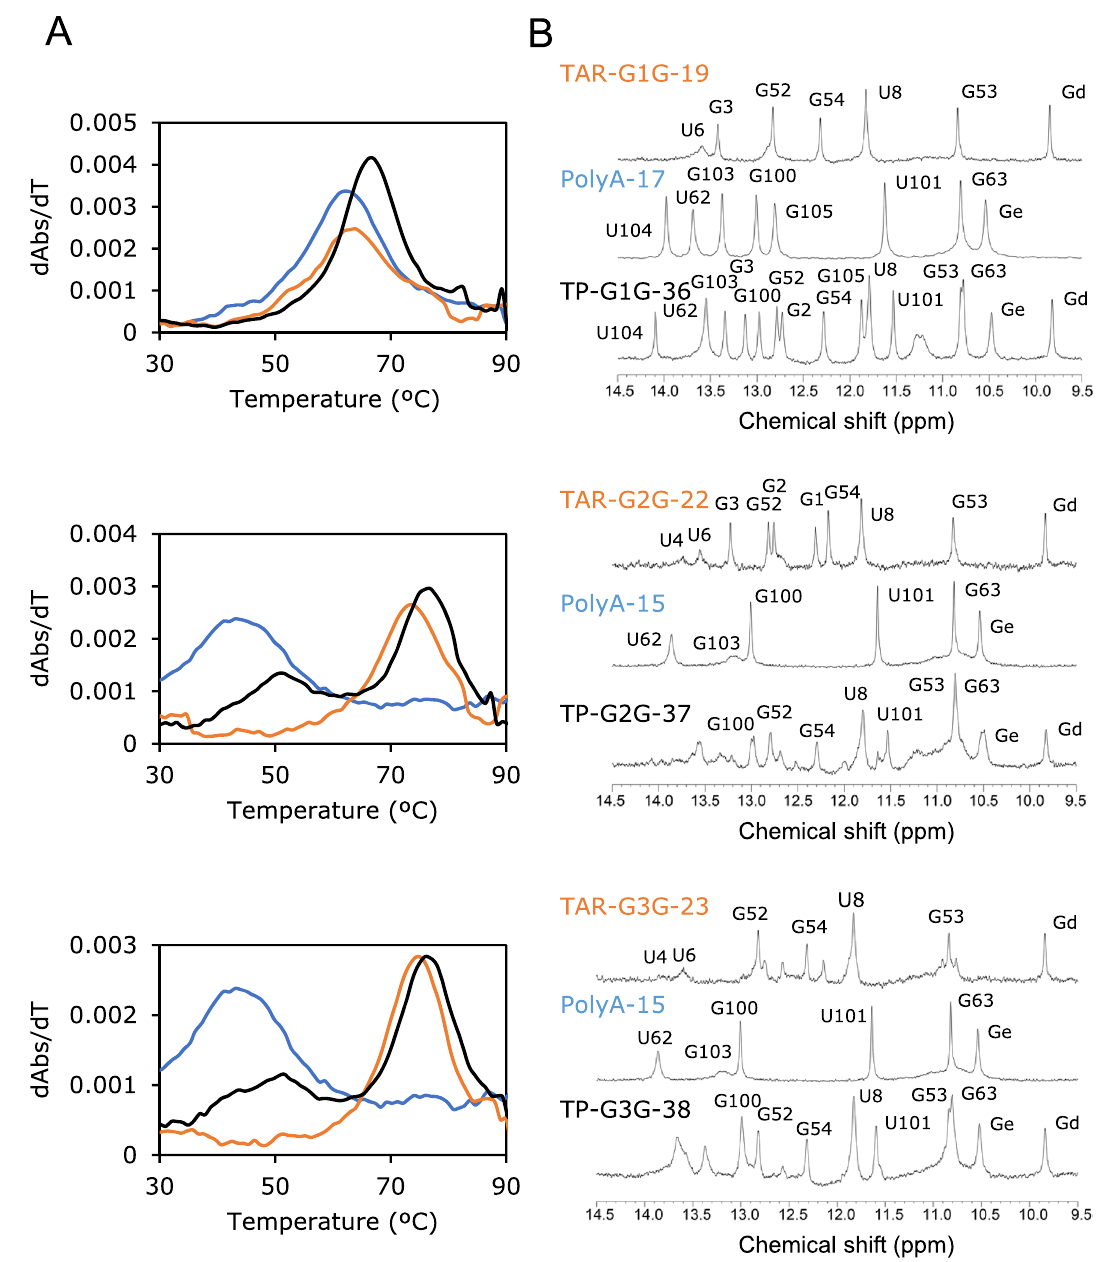
Figure 3. Characteristics of model RNAs analysed by thermal melting and NMR. ( A ) The first derivatives of UV melting curves for TP-G1G-36, TP-G2G-37, and TP-G3G-38 with the corresponding sub-fragments. The absorbance at 260 nm was shown in the temperature range of 30 to 90 °C. Model RNAs, TAR and Poly-A sub- fragments are coloured black, orange and blue, respectively. ( B ) Imino proton spectra measured at 283